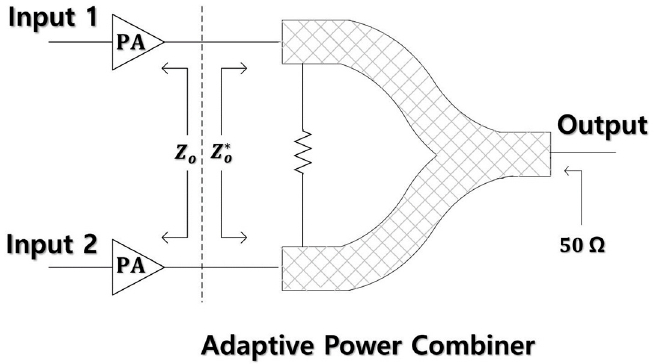
Figure 6. Proposed power module using two power amplifiers and an adaptive power combiner (Re( Z o ) = Re( Z o *) = 31 Ω ).